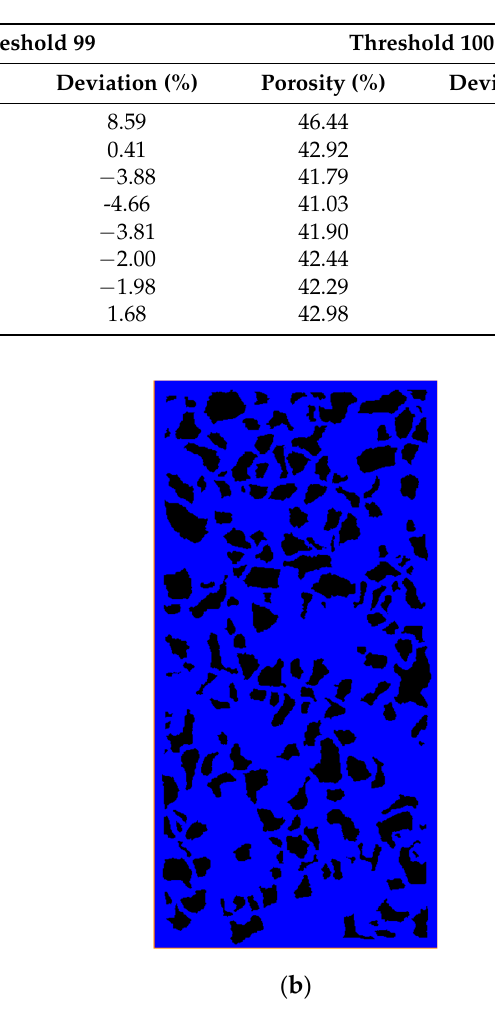
Figure 4. Representative volume element (RVE) of ( a ) untreated sample and ( b ) consolidated soil.